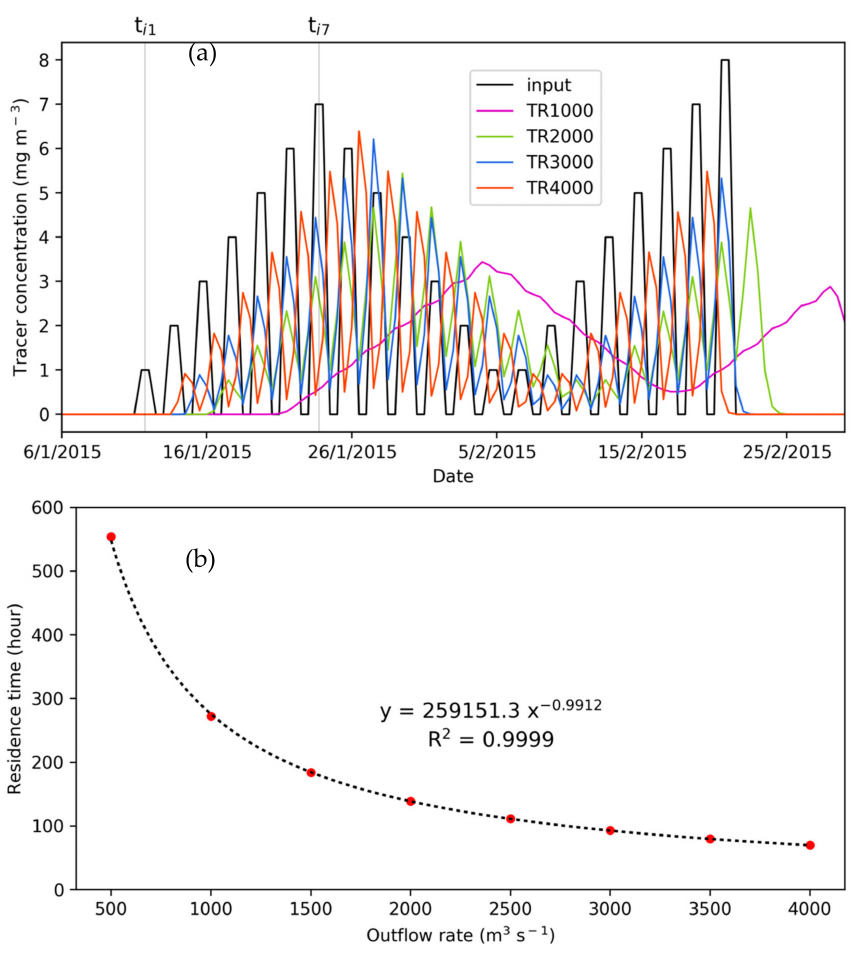
Figure 12. ( a ) Tracer concentration variations at the YHS corresponding to various outflow rates (F2, F4, F6, and F8 are demonstrated in the figure); and ( b ) the exponential relationship between residence time and outflow rate of the Jinghong Reservoir.